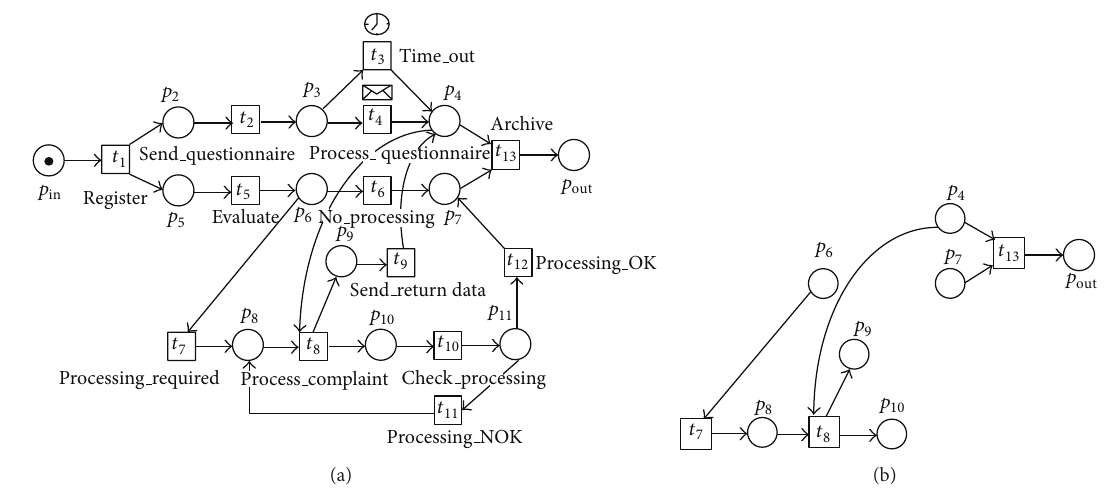
Figure 7: (a) A real-world WF-system ( 𝑁 󸀠󸀠 , 𝑀 󸀠󸀠